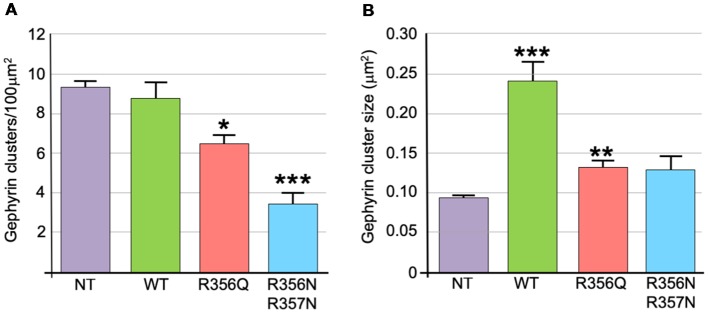
Quantification of gephyrin cluster number and cluster size for wild-type collybistin and mutants R356Q and R356N/R357N in cultured hippocampal neurones. (A) To quantify the effect of these mutants, we measured gephyrin cluster density/100 μm2 in non-transfected neurones (NT = 9.33 ± 0.33, 1.04) and neurones transfected with wild-type collybistin (WT = 8.73 ± 0.88, 2.77) and collybistin phosphoinositide binding mutants (R356Q = 6.42 ± 0.52, 1.65; R356N/R357N = 3.37 ± 0.63, 1.99; mean ± SEM, SD). The gephyrin cluster density was decreased for R356Q but not as much as for R356N/R357N, *p < 0.05; ***p < 0.001 for each mutant respectively compared with either NT or WT, n = 10 neurons each. The total number of clusters counted for density were 283, 273, 189 and 99 for NT, WT, R356Q and R356N/R357N, respectively. For quantification of cluster density, two independent transfections were made for each construct, and all constructs were used in each experiment. A total of 60 dendritic fields (50 μm2 each) per construct from 10 randomly selected neurons (10 neurons/construct, 3 dendrites/neuron, 2 dendritic fields/dendrite) were analyzed. (B) Gephyrin cluster size was NT = 0.095 ± 0.003, 0.011; WT = 0.240 ± 0.024, 0.076; R356Q = 0.132 ± 0.008, 0.026; R356N/R357N = 0.129 ± 0.016, 0.051. Values are mean ± SEM, SD / μm2, n = 10 neurons each. For quantification of cluster size, two independent transfections were made for each construct, and all constructs were used in each experiment. ***p < 0.001 for WT with each of the other plasmids; **p < 0.01 for R356Q compared with NT indicates a slight increase in cluster size in this mutant. The total number of clusters counted for size were 680, 584, 492 and 180 for NT, WT, R356Q and R356N/R357N, respectively. No significant difference was observed for R356N/R357N compared with NT or R356Q. The data were analyzed by one-way analysis of variance with a Tukey-Kramer multiple comparisons test.